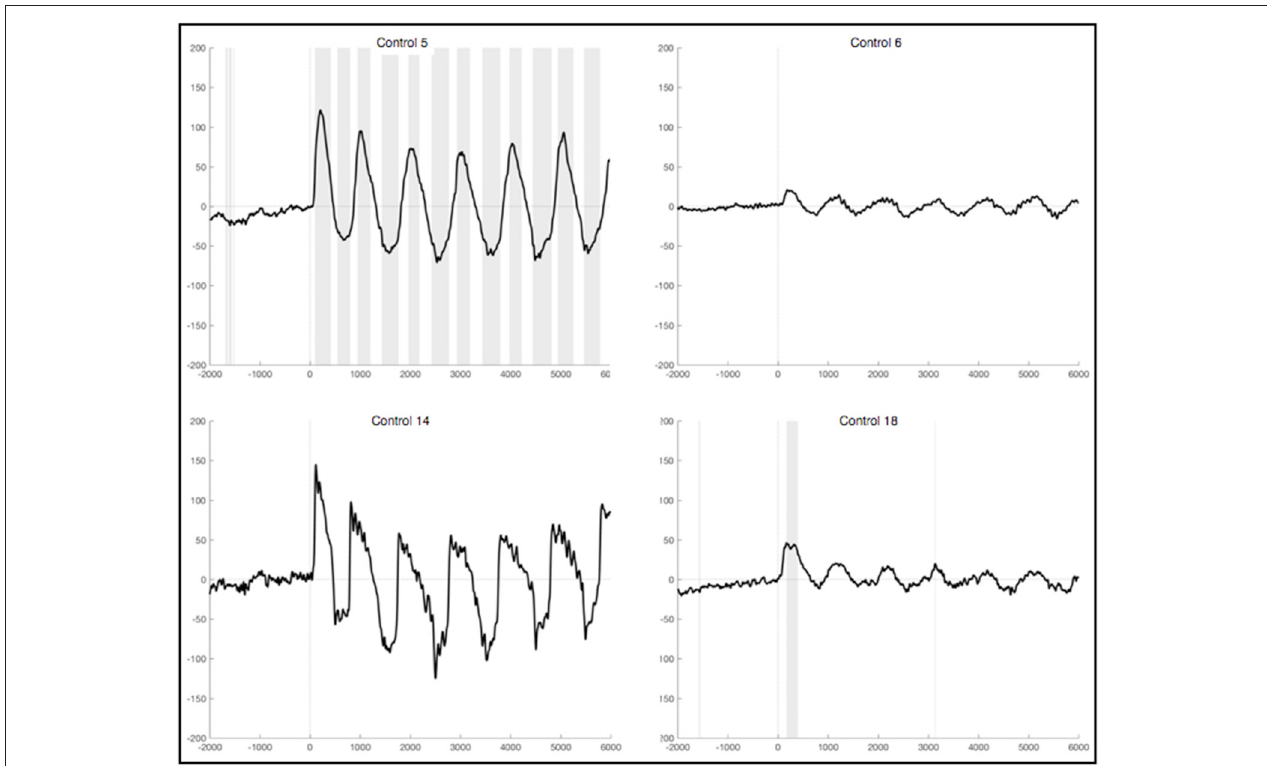
FIGURE 3 | Average ERPs of four healthy subjects recorded on Pz during foot movement execution. Segments are locked to EMG onset (time point 0) and artifacts had been excluded strictly. The x-axis displays time (ms) and the y-axis amplitudes ( µ V). Sections shaded in gray indicate significant differences from the resting condition on a single trial level with p